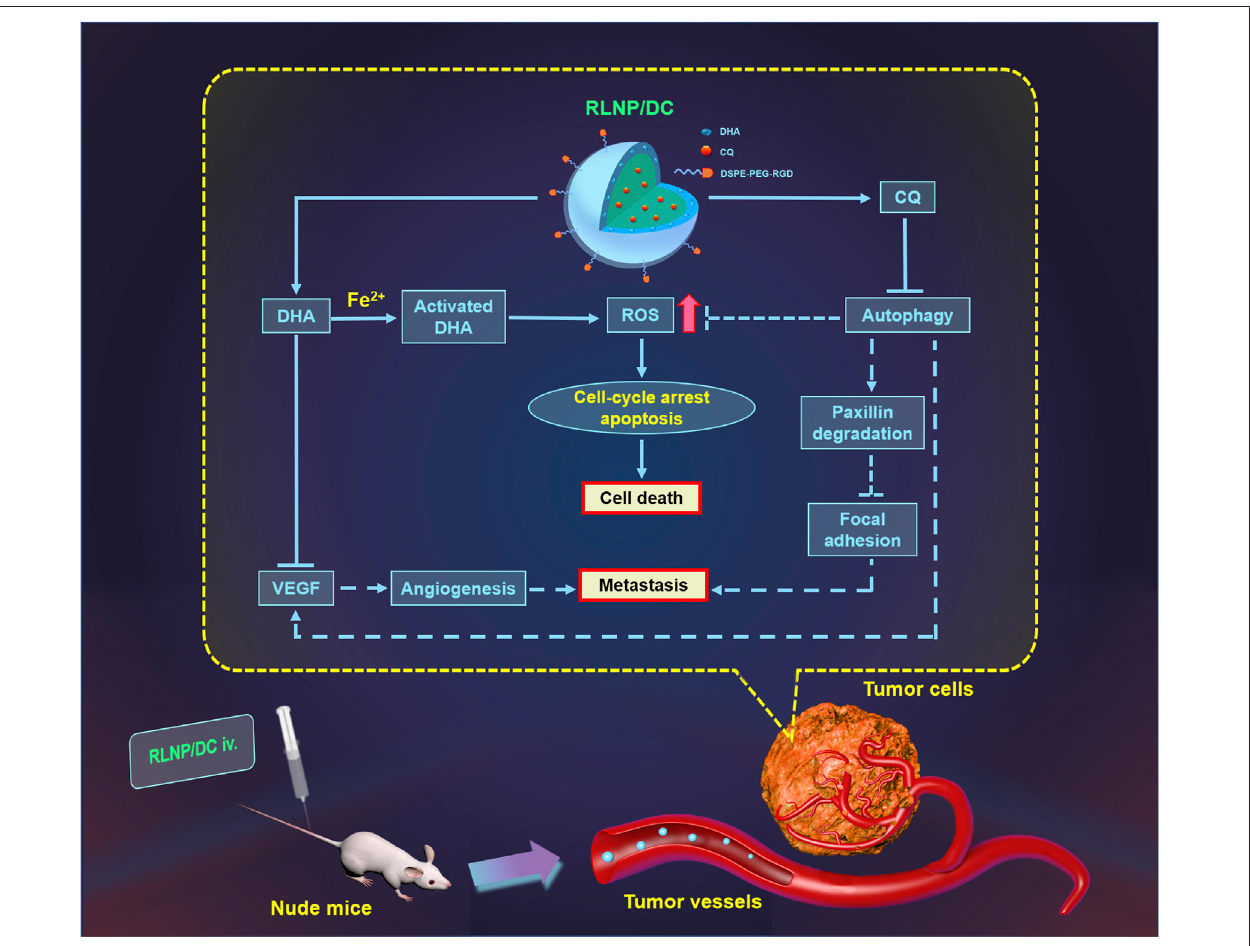
FIGURE 8 | Schematic illustration of suppression of proliferation and liver metastasis of colorectal cancer by RLNP/DC. DHA is activated by Fe 2+ to generate ROS and CQ blocked ROS elimination via autophagy inhibition, which contributed to irreversible upregulation of intracellular ROS level leading to cell death. Moreover, both DHA and CQ exerted anti-angiogenesis activity via down regulation of VEGF, and CQ prevented the degradation of paxillin leading to enhanced focal adhesion of tumor cells to the ECM, resulting in anti-metastasis effect on colorectal cells. RLNP plays an important role for targeted co-delivery of DHA and CQ to the primary tumor region aiming at improved anti-tumor ef fi cacy against colorectal